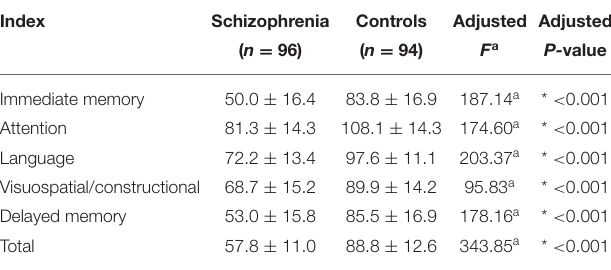
TABLE 3 | Total and index scores on the RBANS in schizophrenia vs. controls.